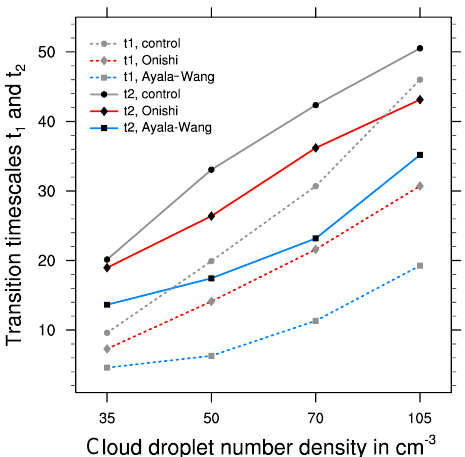
Figure 7. Transition timescales t 1 (dashed, grey symbols) and t 2 (solid, black symbols), defined as the time when the domain- averaged rain rate exceeds 0.1 and 0.8mmday − 1 , respectively, for the first time. The transition times are averaged over multiple simu- lations with different random